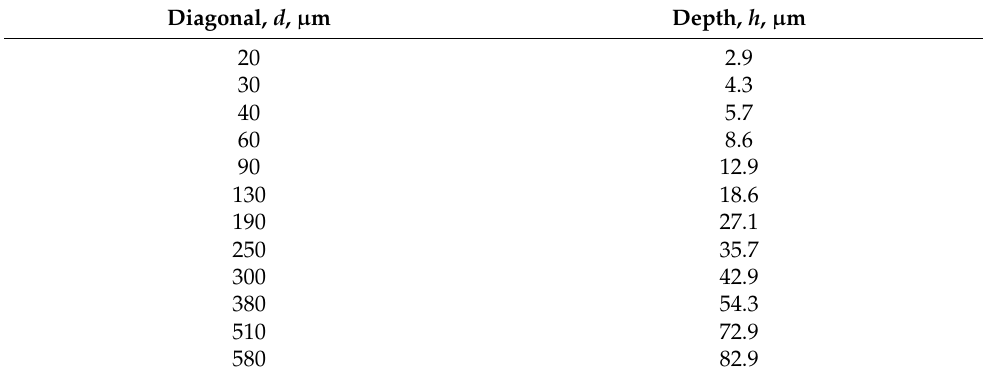
Table 1. The indentation properties selected for determining the surface hardness.